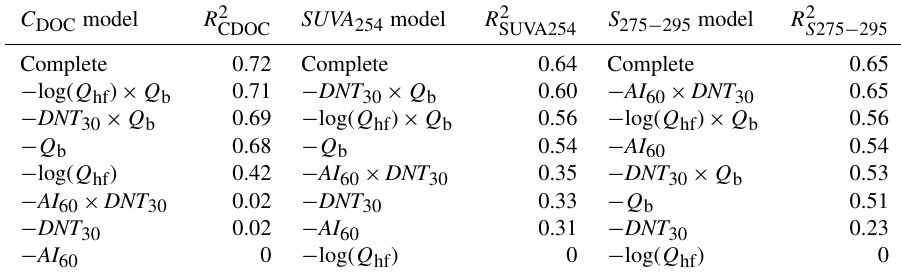
Table 4. Evaluation of the whole dataset model by dropping the least influencing variable according to AIC, starting from the complete models (Eq.